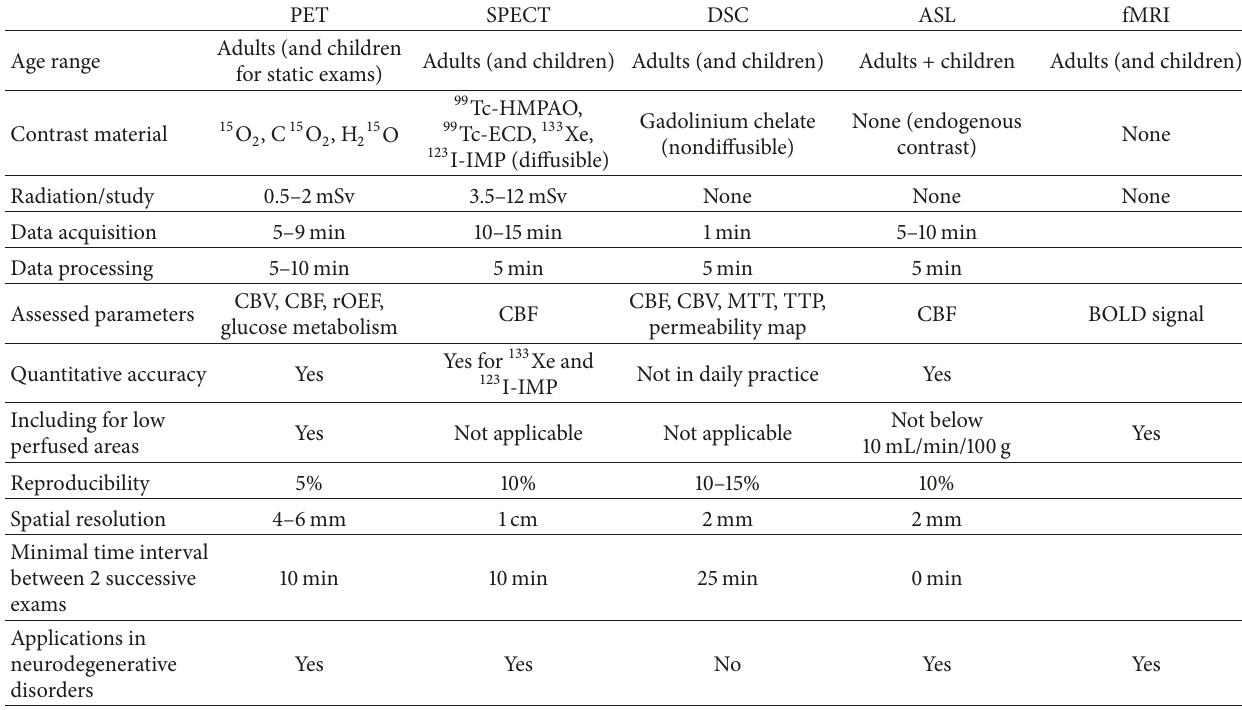
Table 2: Overview of the imaging techniques dedicated to brain hemodynamics (adapted from Wintermark et al. [27]). PET SPECT